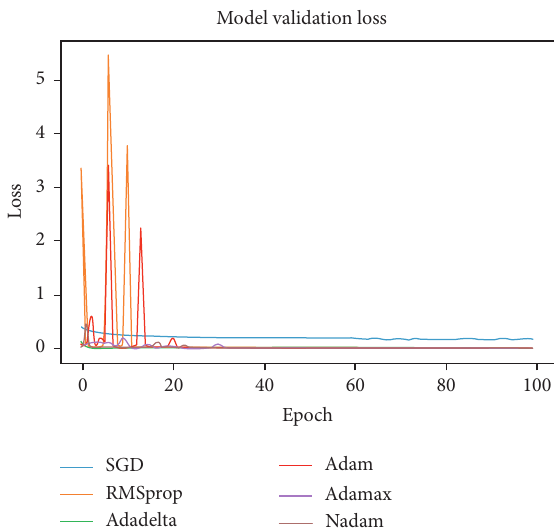
Figure 8: Learning curve with different optimizers.